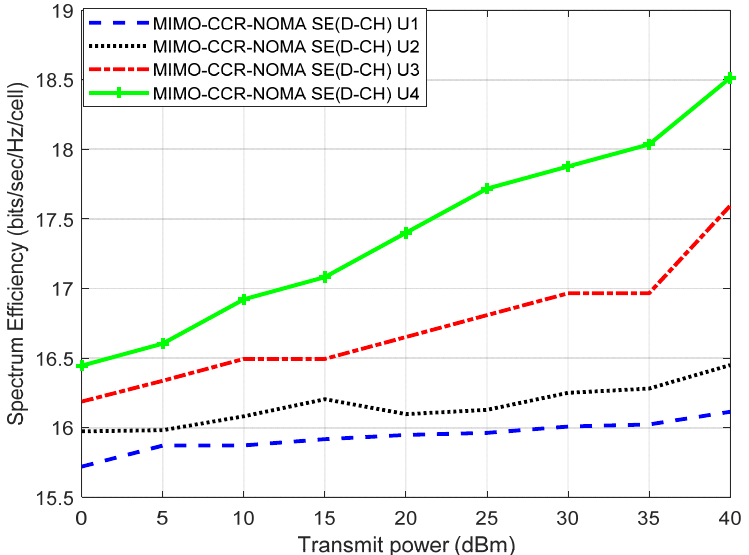
Figure 9. SE versus transmitting power for 4 users’ 64 × 64 MIMO DL-NOMA PD with D-CH CCRN.